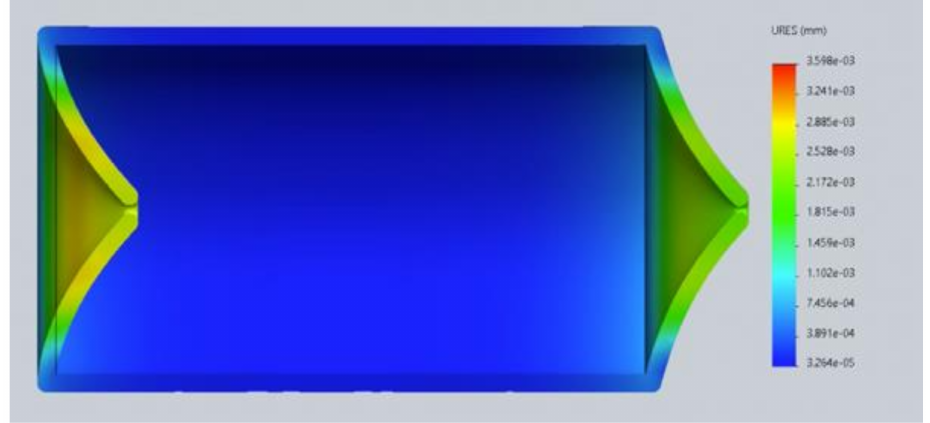
Figure 10. Version 2.0 of the lymphatic vessel: deformation test with both valves closed